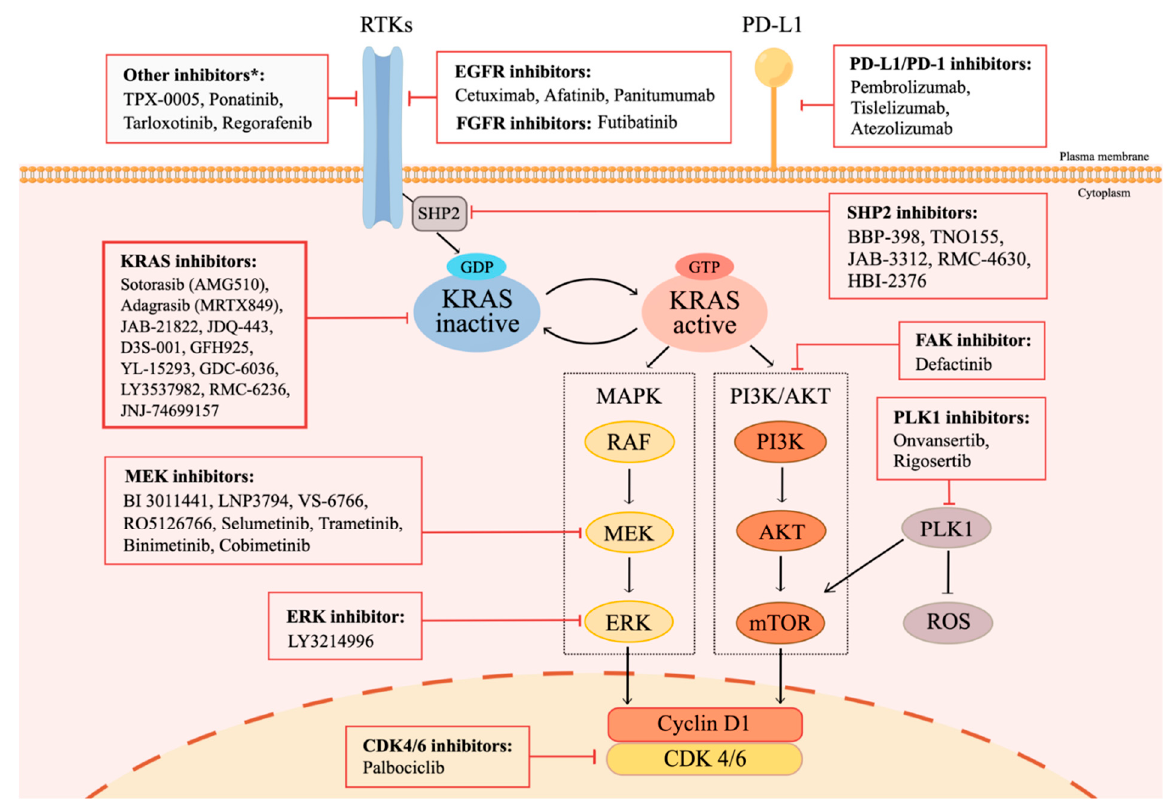
Figure 1. Signaling Pathways Related to KRAS Mutations, and Potential Treatment Strategies. * KRAS switches between a guanosine diphosphate (GDP)-bound inactive state and a guanosine triphosphate (GTP)-bound active state. Normally, KRAS is bound to GDP and remains inactive. Activation through receptor tyrosine kinases (RTKs) leads to the activation of the guanine nucleotide exchange factor (GEF) family, which subsequently triggers the exchange between GDP and GTP. GTP-bound active KRAS transduces downstream signals, including mitogen-activated protein kinase (MAPK) pathway and the phosphoinositide 3-kinase (PI3K) pathway, which are responsible for cell proliferation, cell cycle regulation, cell survival, and cell differentiation. The treatment approaches of KRAS mutant patients include therapies targeting KRAS, and factors involved in the KRAS mutation pathways, such as RTKs, SHP2, PI3K pathway elements, MAPK pathway elements, and CDK4/6. ICIs are also included, considering the potential effect on KRAS mutant patients. This figure was created using Figdraw.